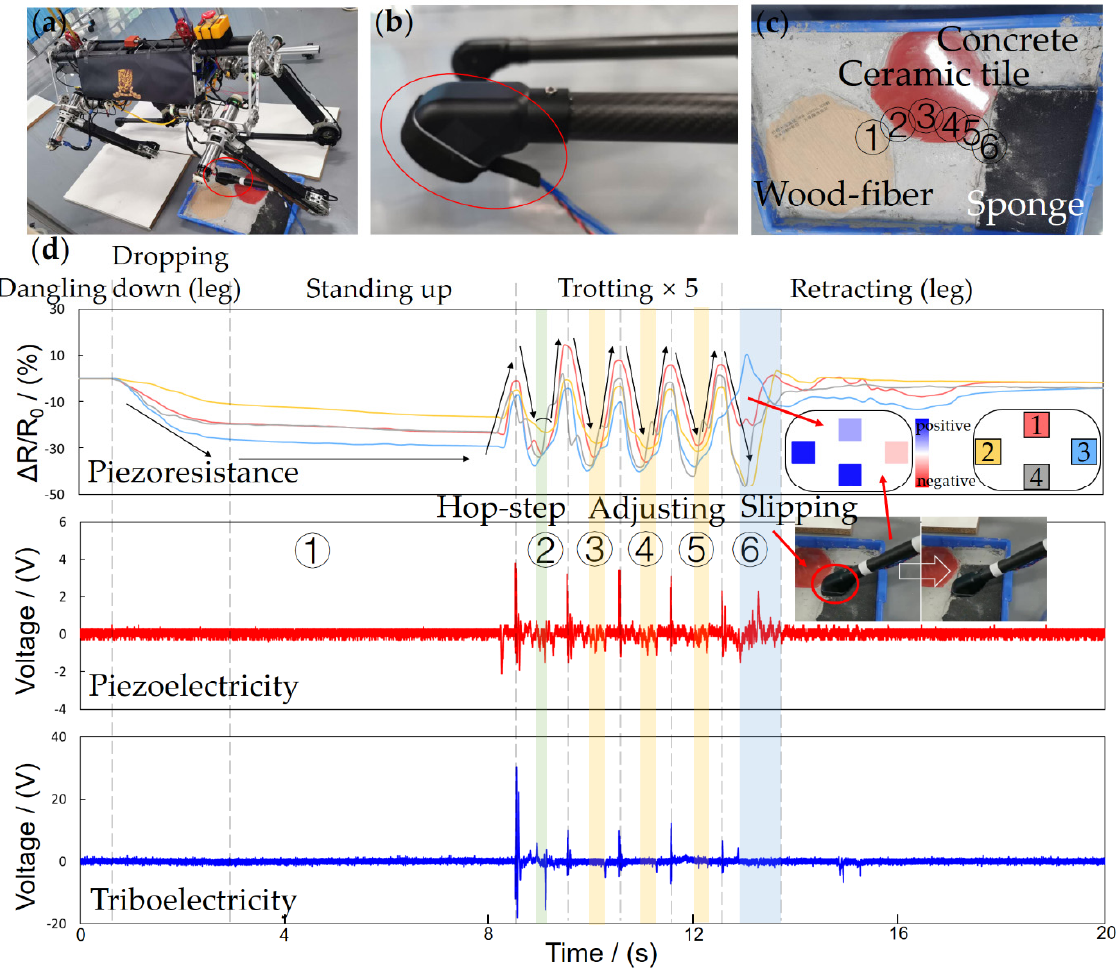
Figure 9. The experiment of FMSS mounted on the foot of ( a , b ) a large size quadruped robot Pegasus without changing the original quadruped foot and leg design. ( c ) The floor pad design with different terrains and step points follows the order from 1 to 6. ( d ) FMSS signals in the whole process, which are separated into five states according to the robot’s